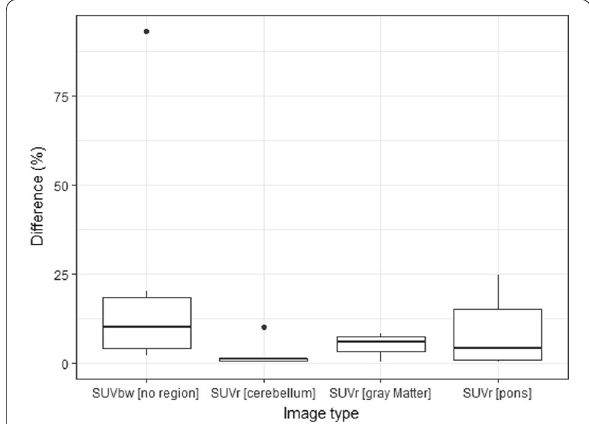
Fig. 5 Box plots of maximum signal differences. Absolute percentage differences of the maximum signal in the pituitary gland, comparing pairs of images from healthy volunteers normalized to different